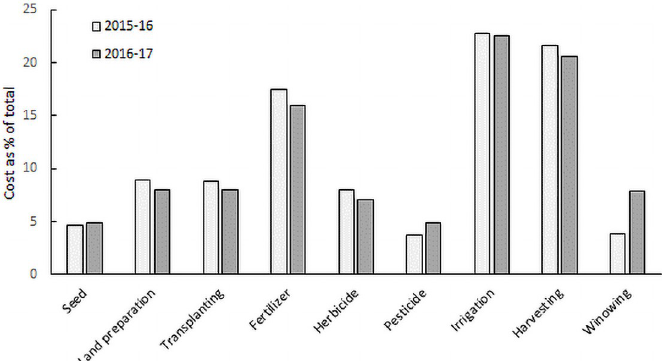
Fig 3. Paid-out costs of different inputs as percentage of total: Seed (including seed, nursery preparation and seedling development), land preparation (tillage), transplanting (including seedling uprooting), fertilizer, herbicide (including weeding), pesticide, irrigation, harvesting (crop cutting, carrying, and threshing), winnowing (including drying) for Boro rice cultivation in 2015–16 and 2016–17.